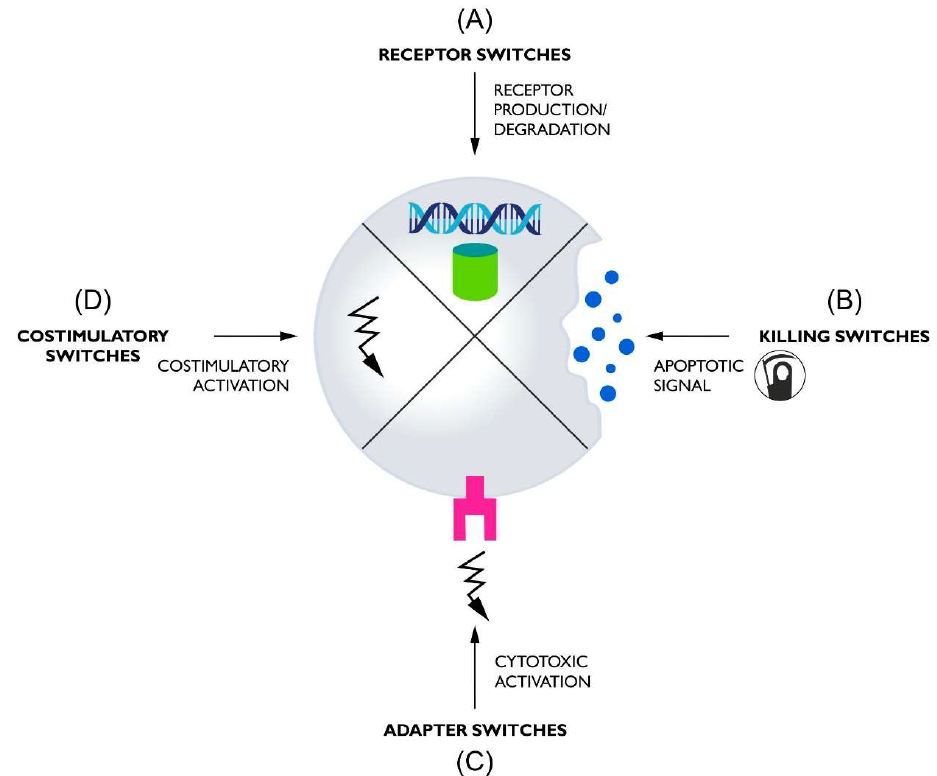
Figure 1. The diagram shows the general mechanism of the four classes of switches used to control CARs. ( A ) Receptor switches oversee the presence of the CAR protein in the cell by regulating its formation or elimination. ( B ) Killing switches control CAR-T activity by killing cells through apoptosis, triggered by a control molecule. ( C ) Adapter switches control receptor activation through a molecule mediating contact between CAR and the tumor antigen. ( D ) Costimulatory switches provide additional costimulation if appropriately